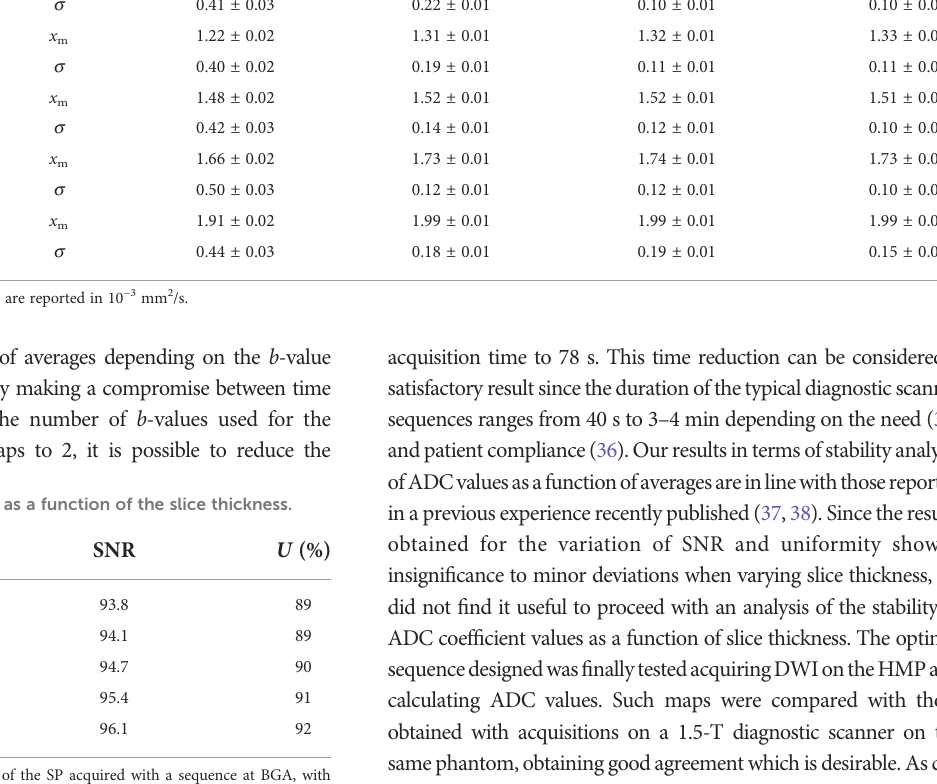
Values are calculated on the images of the SP acquired with a sequence at BGA, with gradient in the “ slice ” direction and a b-value of 500 s/mm 2